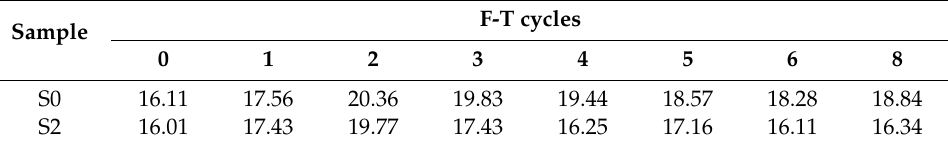
Table 5. D h under F-T cycles ( μ m).